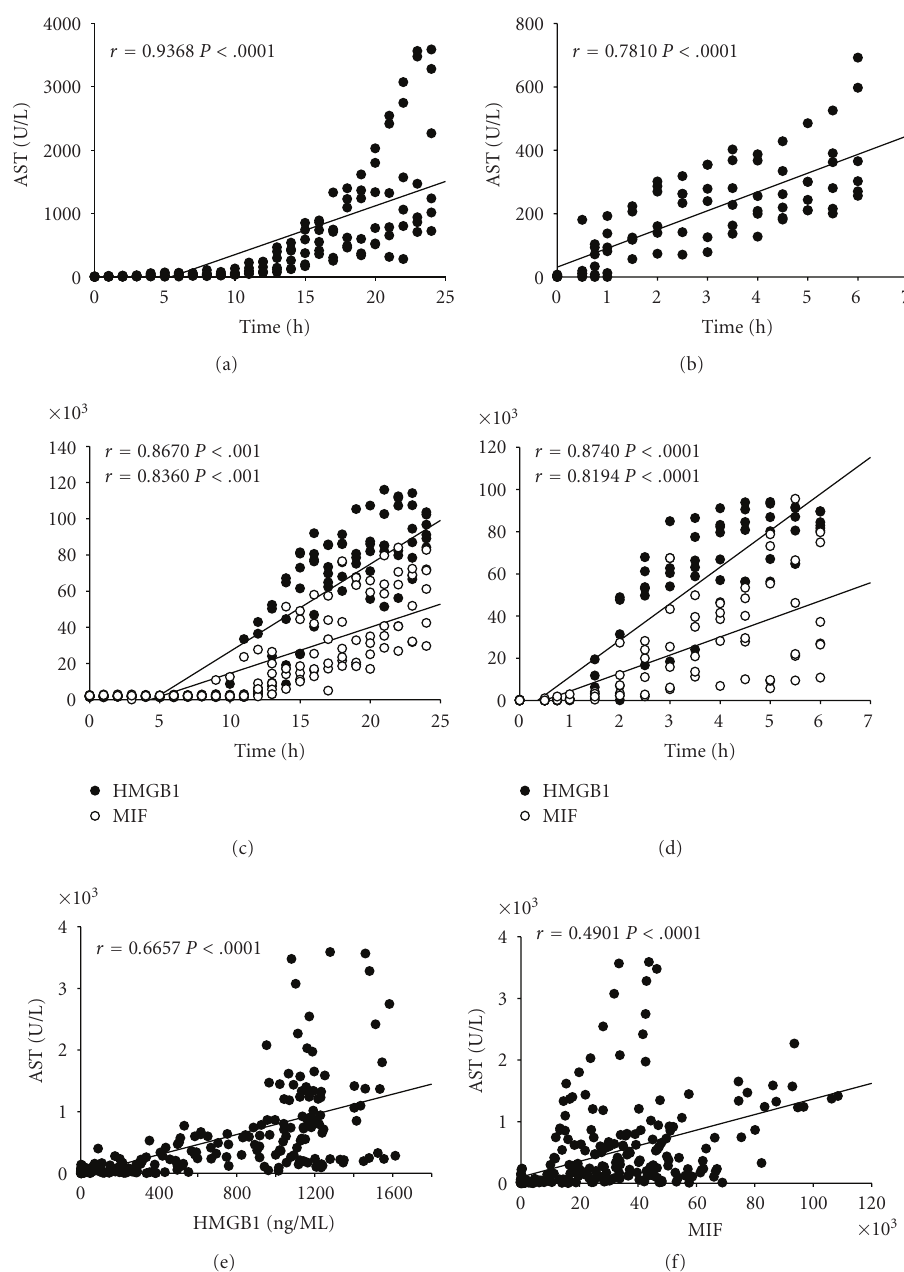
Figure 6: Correlation of E ffl uent HMGB1 and MIF with liver enzymes (AST) and ischemic time. E ffl uent AST positively correlated with cold or warm ischemic time ((a) and (b)), respectively, ( P < . 0001). For HMGB1, the values represent the density of band using Image J program ((c) and (d)), or the values represent the concentration quantified by recombinant standard (e). For MIF, the values represent the density of band using Image J program. E ffl uent HMGB1 and MIF levels correlated moderately with ischemic time ((c) and (d); P < . 0001) and e ffl uent AST ((e) and (f); P < .